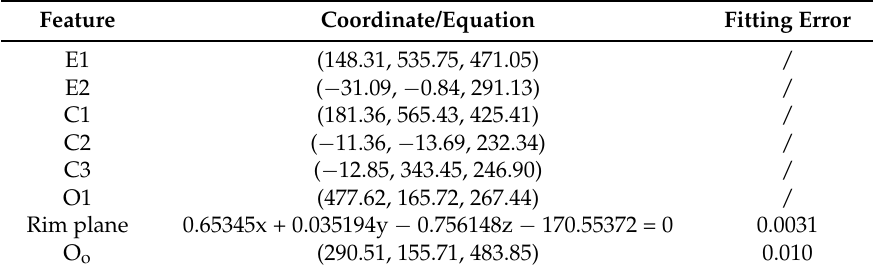
Table 1. Results of the features and the wheel rim plane (in millimeters).